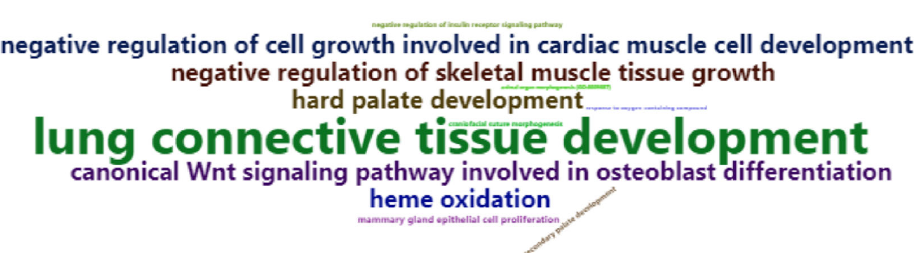
Figure 5. Genome regions of selective signature and GO enrichment analysis. Distribution of Z- F ST and Z- θ π ratio ( θ π ,wild / θ π ,Tibetan ) ( A ). Each dot represents a 10 kb non-overlapping window, red and green lines represent the 95th and 99th quantile, respectively. Wordcloud plot showed the interesting GO enrichment terms ( B ).